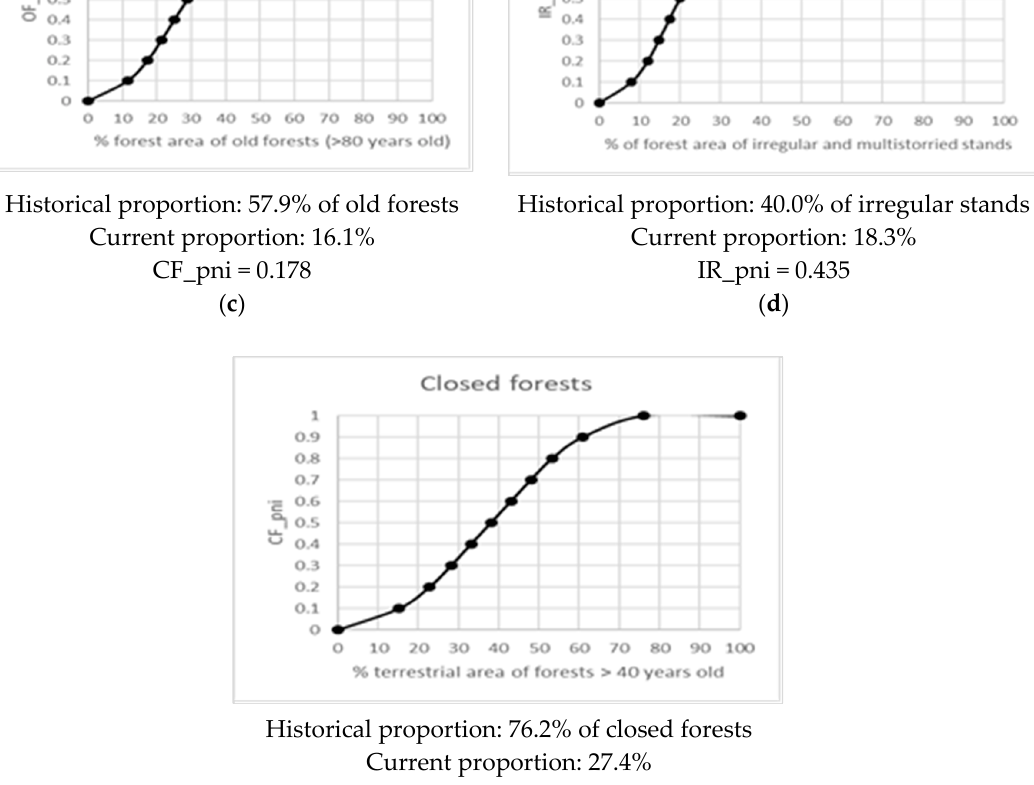
Figure A3. Curves determining the potential naturalness index to evaluate the condition indicators (condition_pni) for FM-B using local studies for reference data: ( a ) coniferous cover type; ( b ) late successional characteristic species; ( c ) old forests; ( d ) irregular stands; ( e ) closed forests.